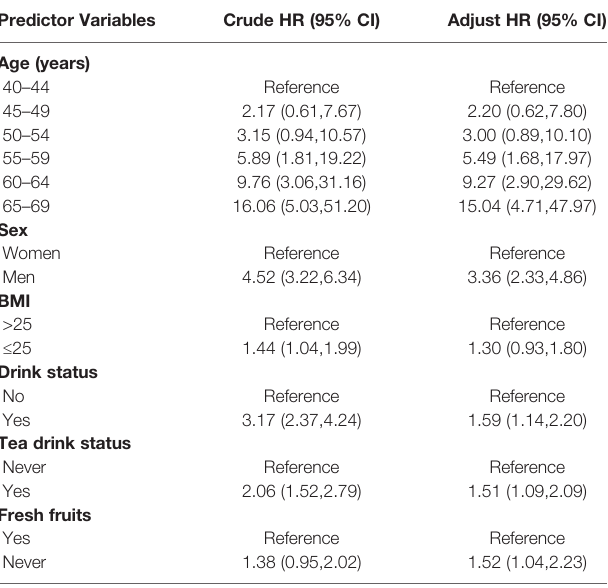
TABLE 3 | Adjusted hazard ratio of risk factors associated with ESCC in the multivariable Cox model. Predictor